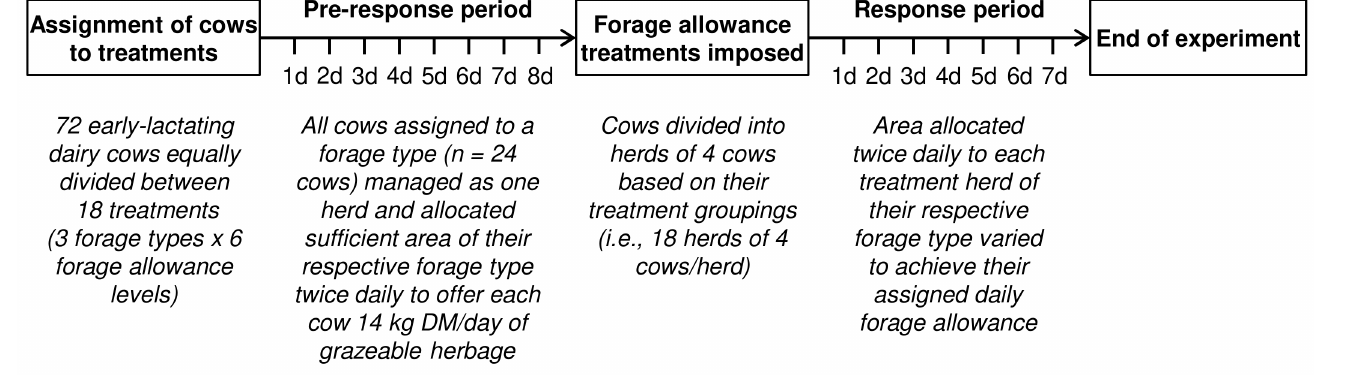
Figure 1. Schematic diagram of experimental